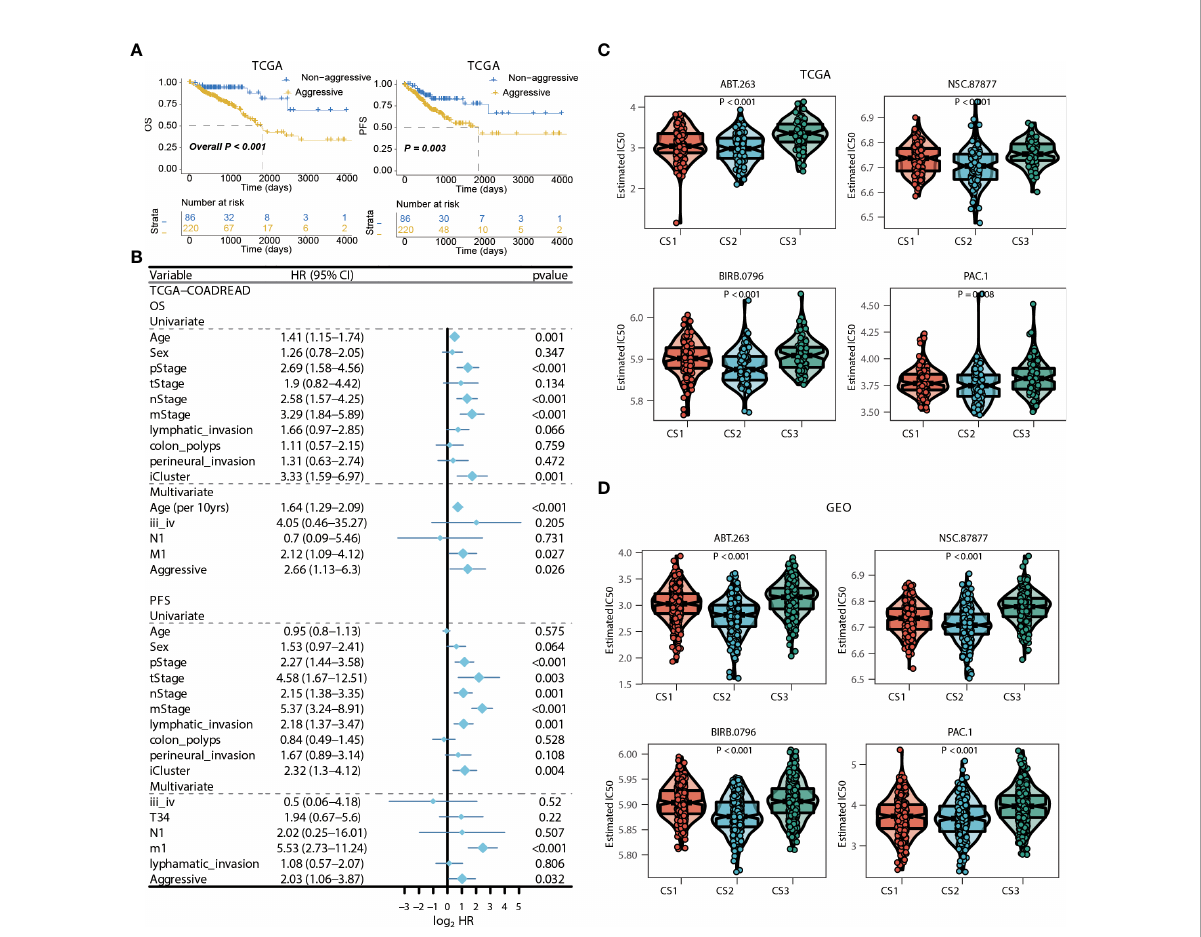
FIGURE 7 Identi fi cation of transcriptome biomarkers for colorectal cancer subtype. (A) KM of os using movics agreesiveness in coadread of tcga. (B) Forest plot showing the hazard ratio (95% CI) in univariate and multivariate Cox regressions with the corresponding P values. (C, D) Boxplot showing the distribution of estimated IC50 among three cancer subtypes based on GDSC database, (C) TCGA, (D)